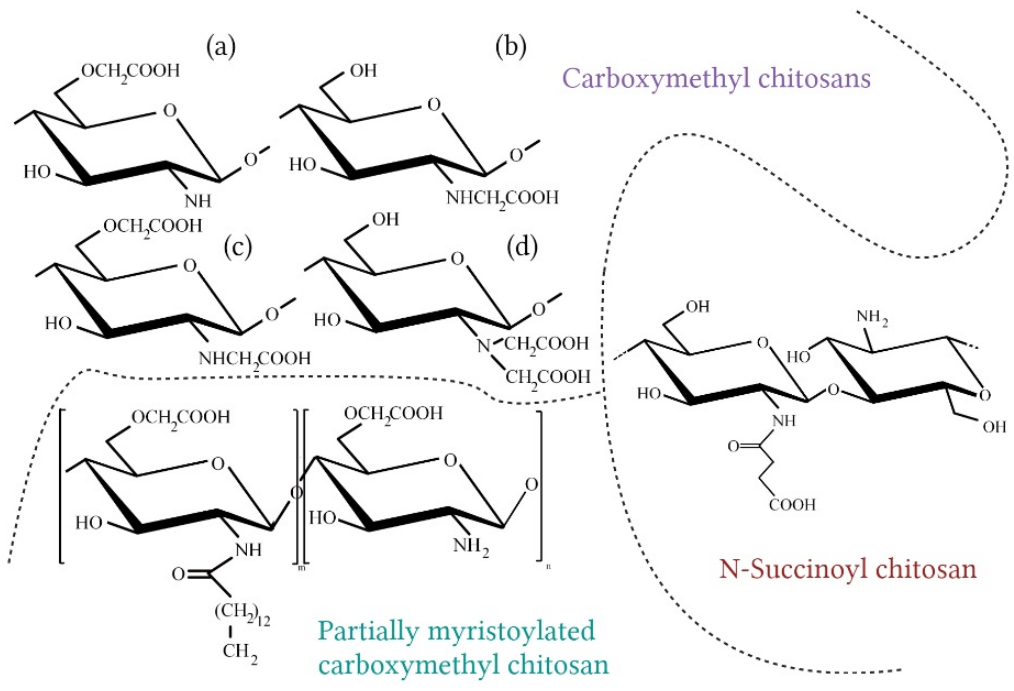
Figure 7. Selected chitosan derivatives for cosmetic applications ( a ) O-carboxymethyl chitosan; ( b ) N-carboxymethyl chitosan; ( c ) N,O-dicarboxymethyl chitosan; ( d ) N,N-dicarboxymethyl chitosan (Created with BioRender.com; accessed on 13 February 2023) [95,115 – 117].